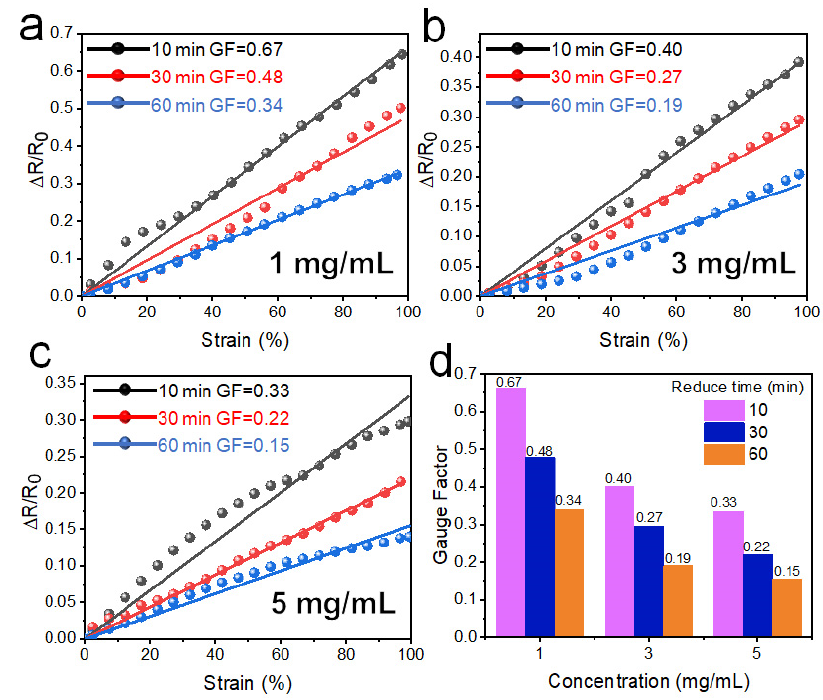
Figure 9. Strain-sensing curves for different reduction times at concentration of ( a ) 1 mg mL − 1 , ( b ) 3 mg mL − 1 , and ( c ) 5 mg mL − 1 . ( d ) Statistical bar chart of GF for various concentrations and reduction times.